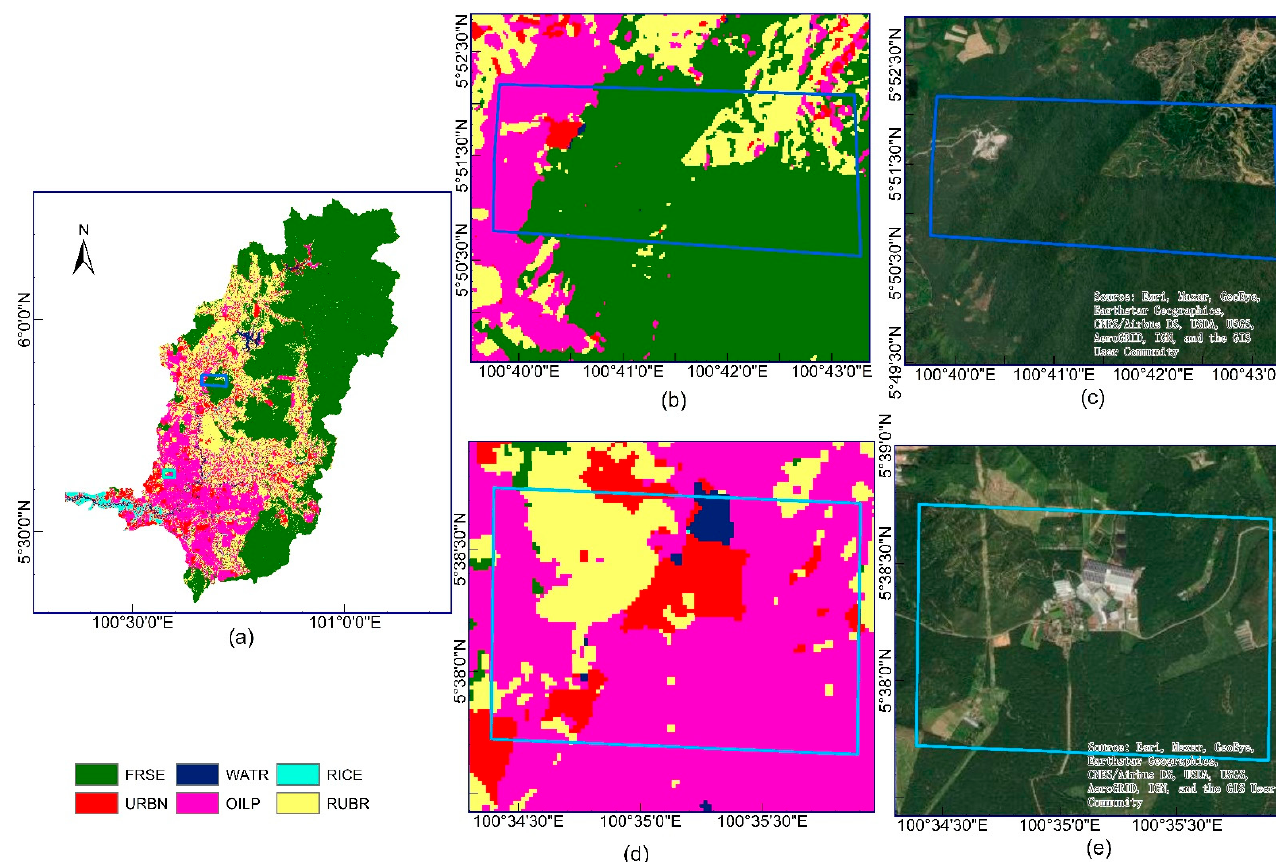
Figure 8. Comparison of the 2020 MRB LULC maps ( a , b , d ) and the high-definition images (Source: Esri, Maxar, GeoEye, Earthstar Geographics, CNES/Airbus DS, USDA, USGS, AeroGRID, IGN, and the GIS User Community) of the basin ( c , e ). Table 5. Accuracy assessment of LULC